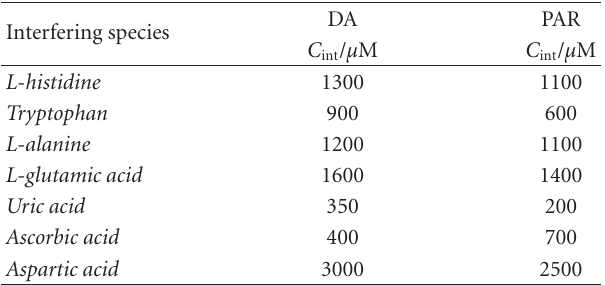
Table 1: Maximum tolerable concentrations for common interfer- ing species.